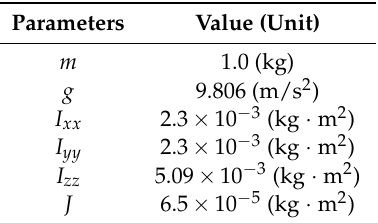
Table 1. The model parameters for the dynamics of a